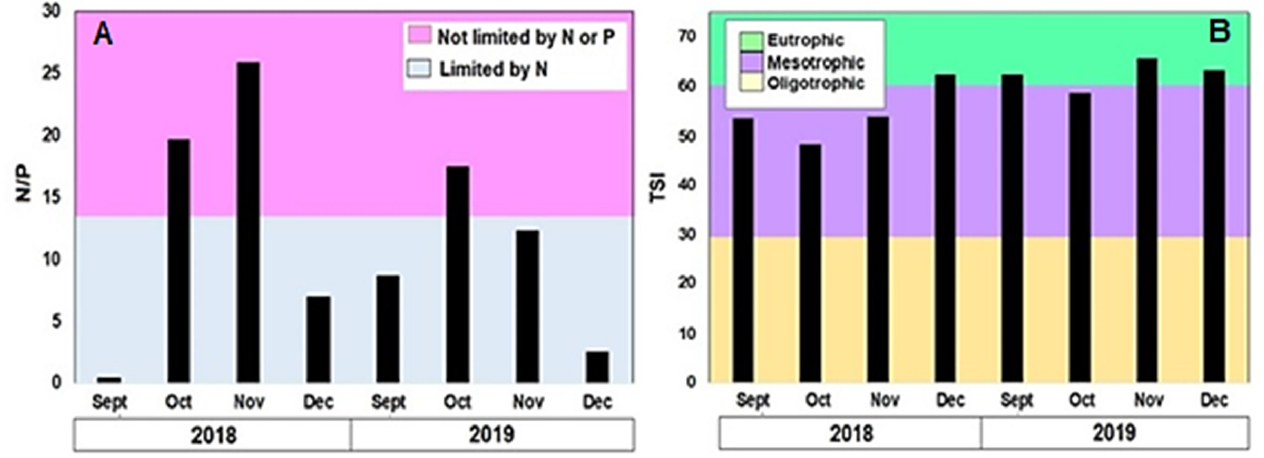
Figure 3. Sample classification by ( A ) N/P ratio and ( B ) trophic status of the reservoir (TSI), according to the Carlson